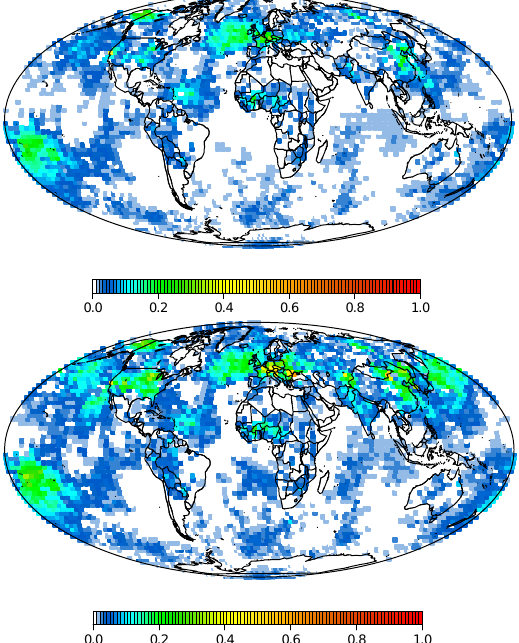
Fig. 4. Annual mean (for 2003) error reduction (shown as a fraction of 1) for the reference data set (upper panel) and the full data set (lower panel).